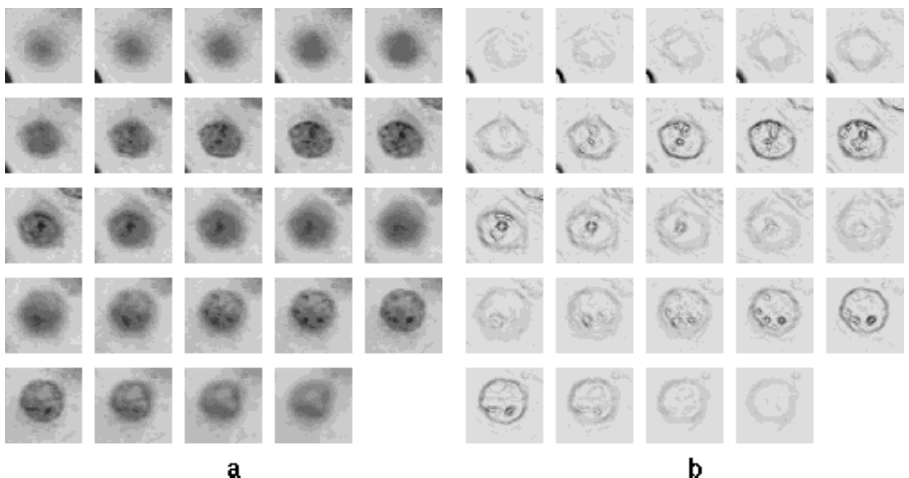
Fig. 2. Sequential z -section images of a complete overlap between two nuclei. (a) Intensity images, (b) gradient images. Size – x,y 11 µ ; z interval 1 µ .